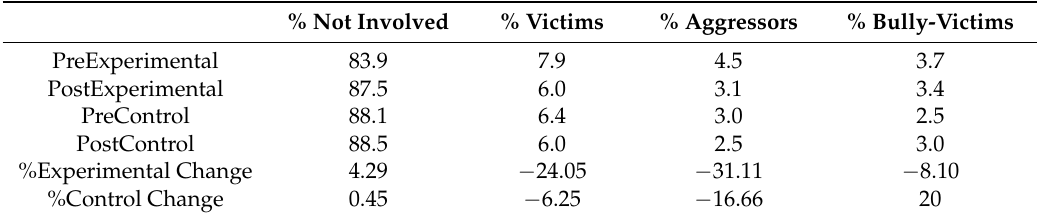
Table 2. Percentages of involvement in the different roles of